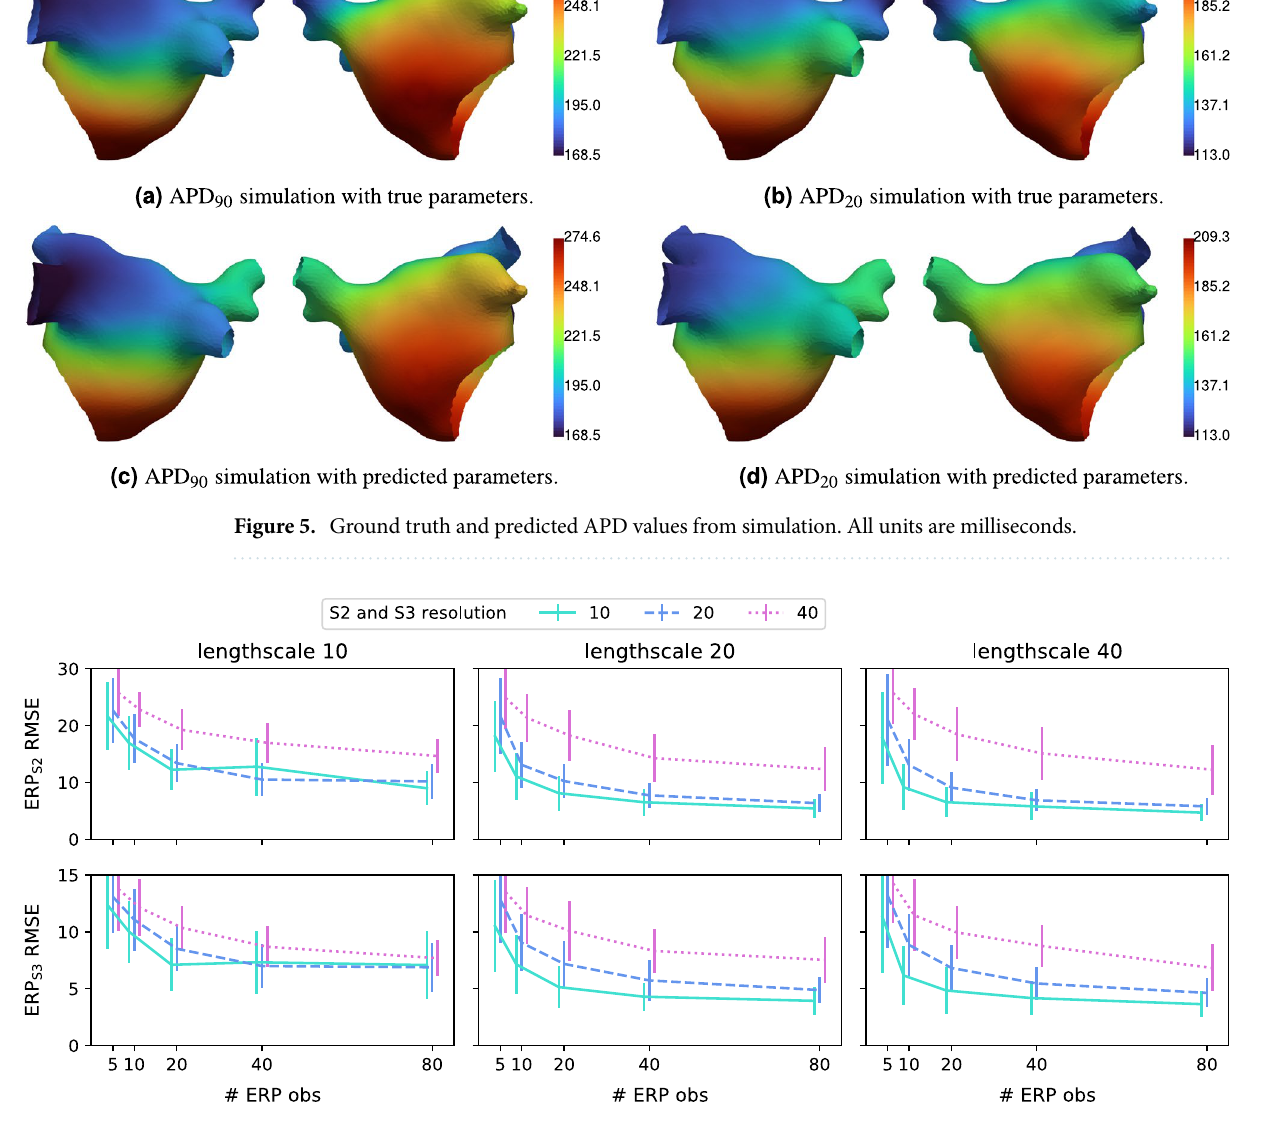
Figure 6. Quantitative validation for ERP prediction, for different lengthscales (1 unit kernel lengthscale 3.2 mm), number of observations, and S2 and S3 resolution. The model prediction is from the maximum ≈ a posteriori estimate. 32 basis functions are used for both EP parameter fields. For each combination of lengthscale, observations, and S2 and S3 resolution, 45 different samples of EP parameter fields are generated, and 5 different observation designs are used for each sample. The RMSE scores of ERP for each validation run is calculated over all mesh vertices. The error bars are 1 standard